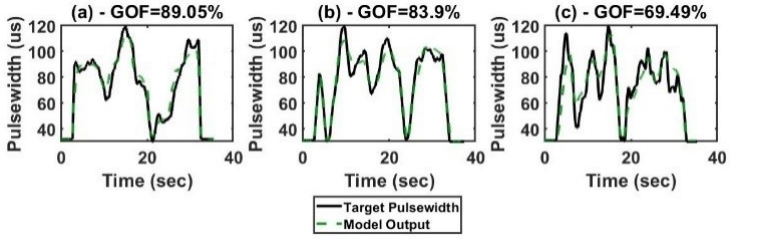
Figure 8. Inverse dynamic NARXNN model results for the first trial with two hidden layers and 20 neurons: ( a ) low-frequency FRN, ( b ) medium-frequency FRN and ( c ) high-frequency FRN.